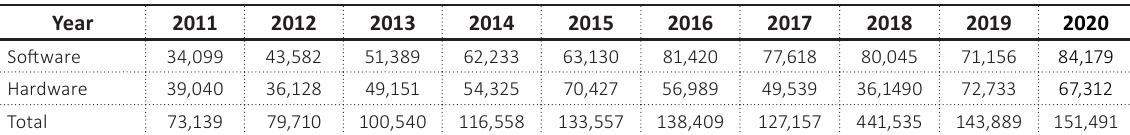
Table 3. Investment in IT software and hardware by the banking and financial sector in Jordan,